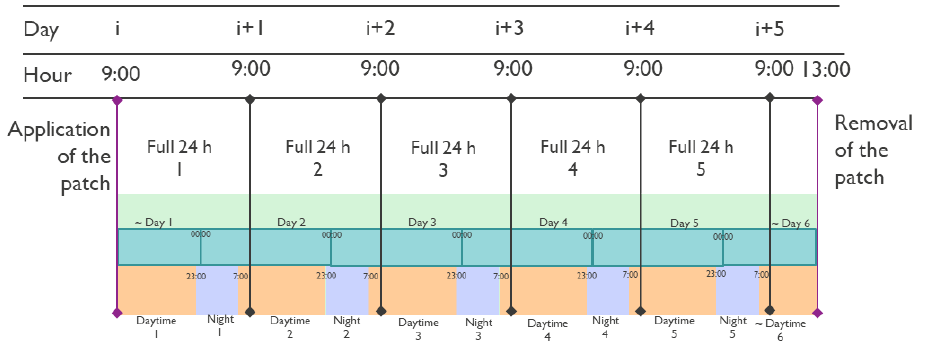
Figure 6. Example protocol timeline and separations used in the analysis. The ∼ symbol indicates the partial full days and